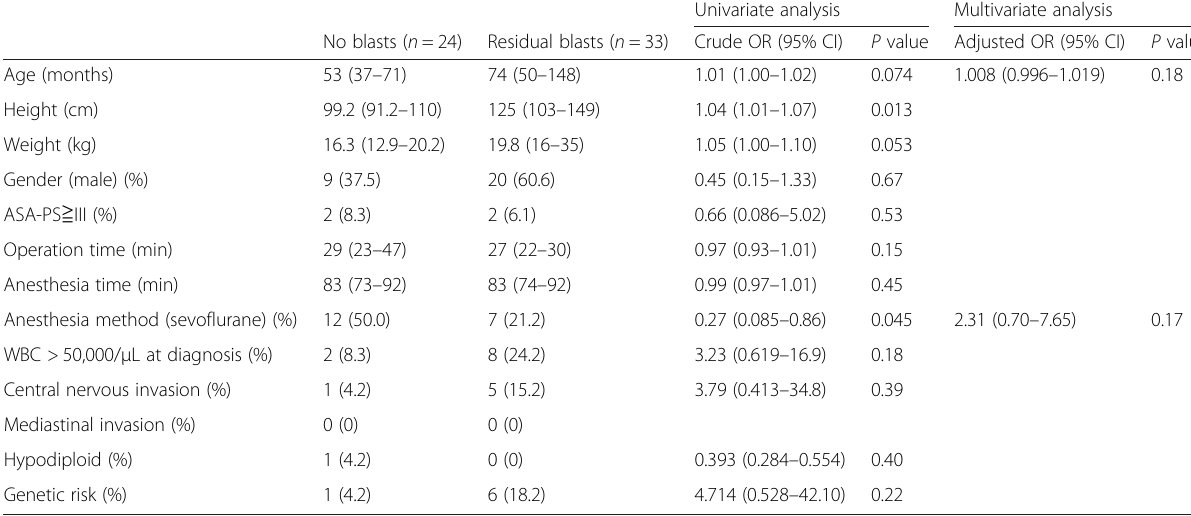
Table 1 Characteristics of patients in the study cohort that were assessed using univariate and multivariate analysis as risk factors for the presence of residual blast cells in peripheral blood on day 8 following prednisone chemotherapy